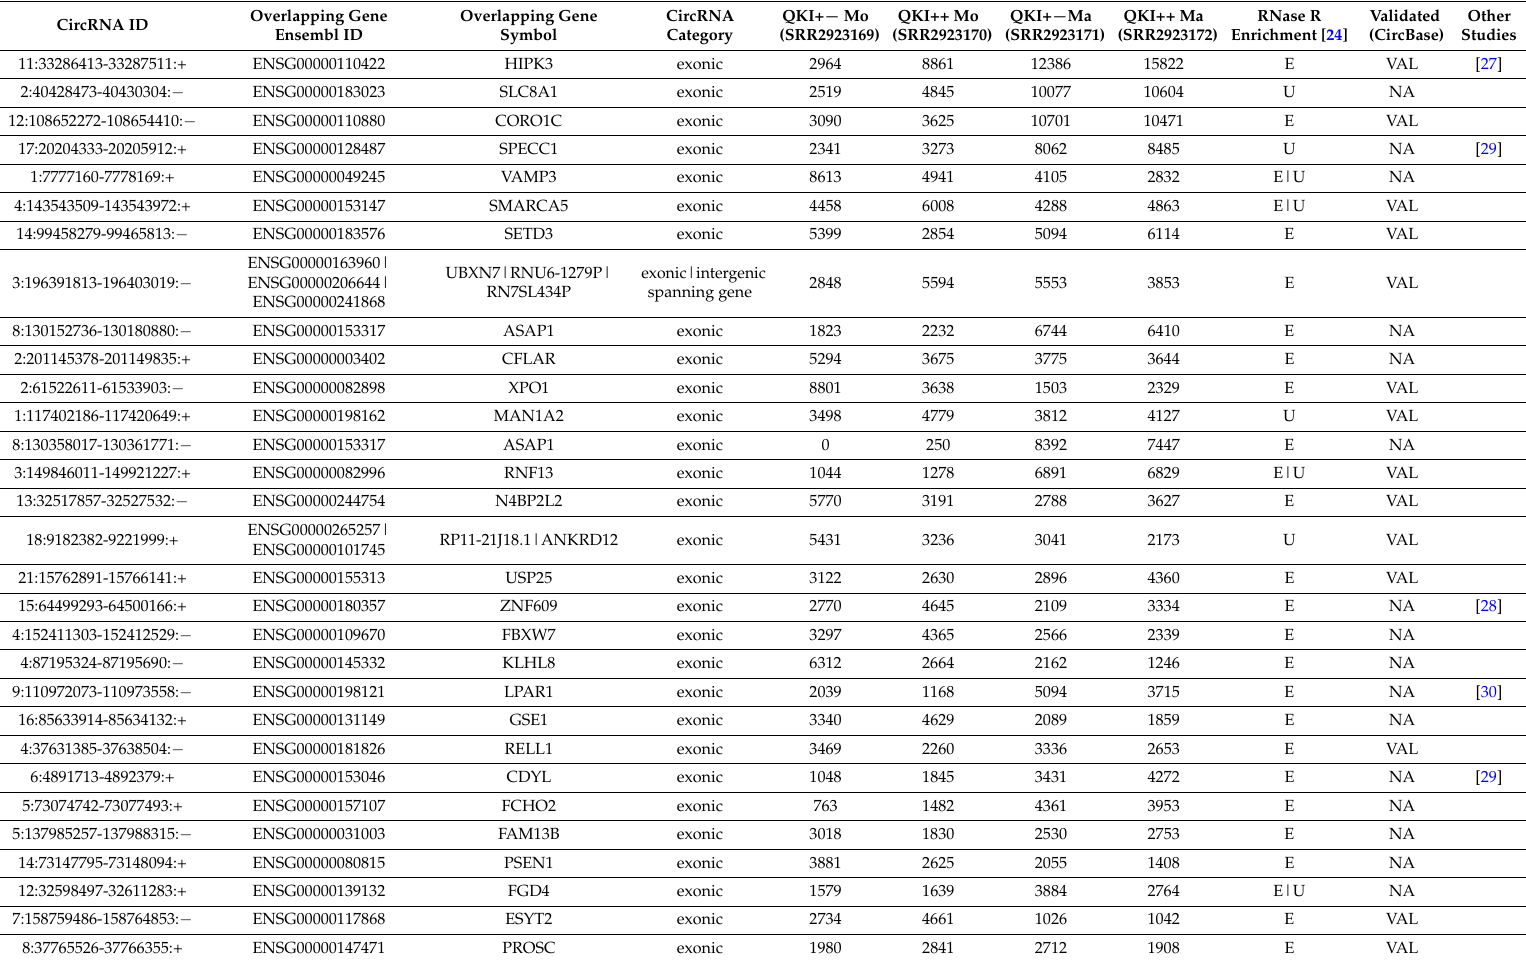
Table 1. The 30 most expressed circular RNAs (circRNAs) with annotations, estimated expression levels (reads per million mapped reads; RPM), enrichment group in Hansen et al. [24], validation reported in circBase, and references of studies that validated specific circRNAs. E = enriched, U = unvaried, NA = not assayed, VAL =